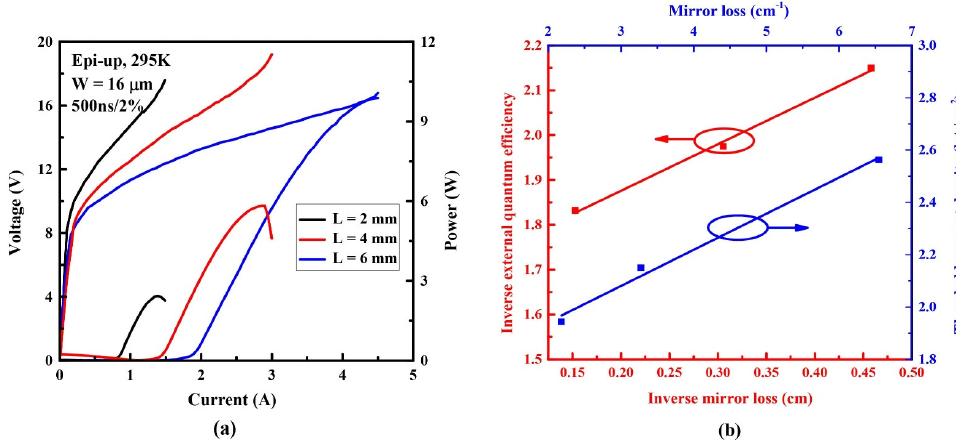
Figure 3. ( a ) the pulsed PIV curves of QCL devices with different length cavities. ( b ) threshold current density dependence on mirror loss (blue line) and inverse external quantum efficiency dependence on inverse mirror loss (red line).